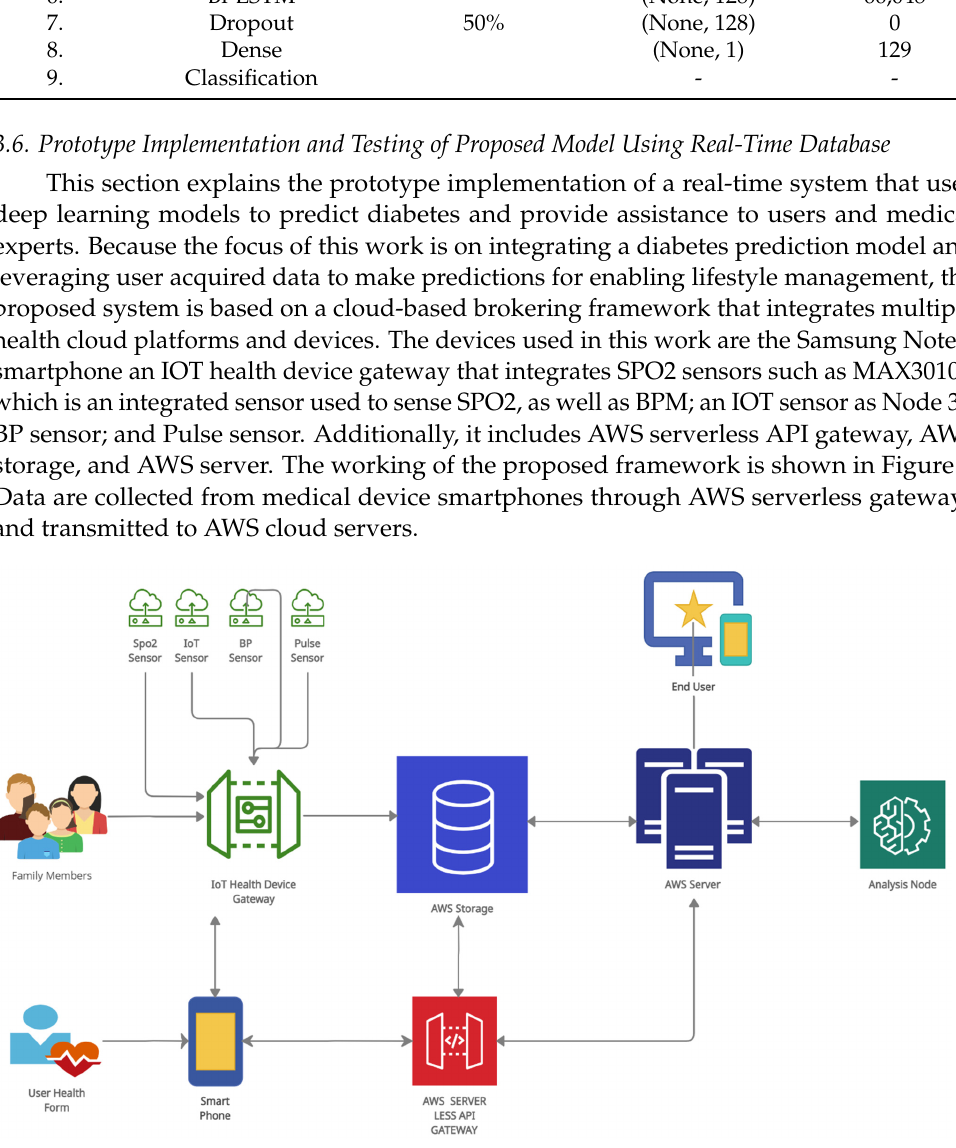
Figure 8. Data integration using real-time proposed framework.